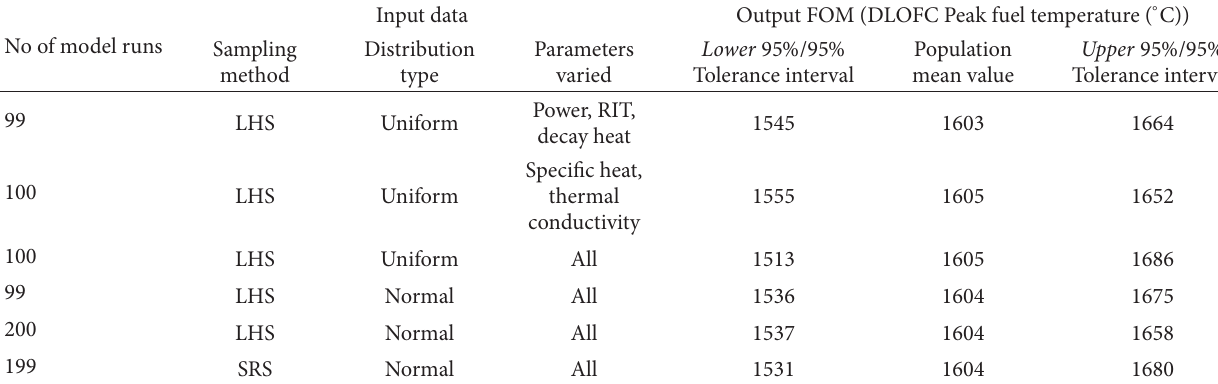
T 4: PEBBED CRP-5 DLOFC uncertainty study